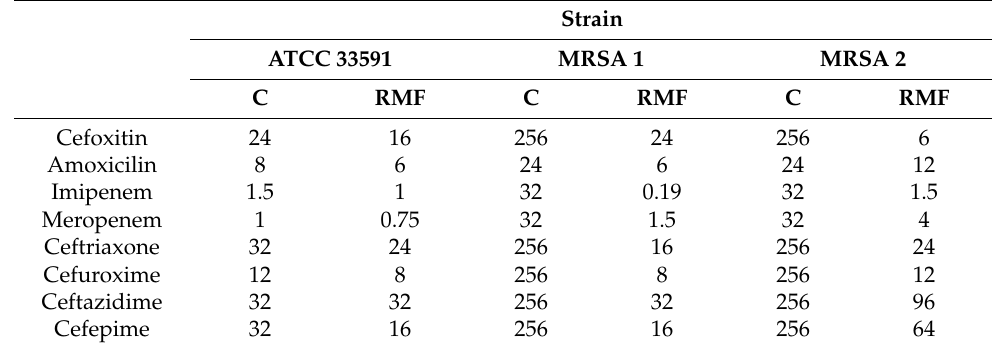
Table 4. MIC values ( µ g/mL) of β -lactam antibiotics for MRSA strains in control and RMF-exposed (5 Hz) cultures.